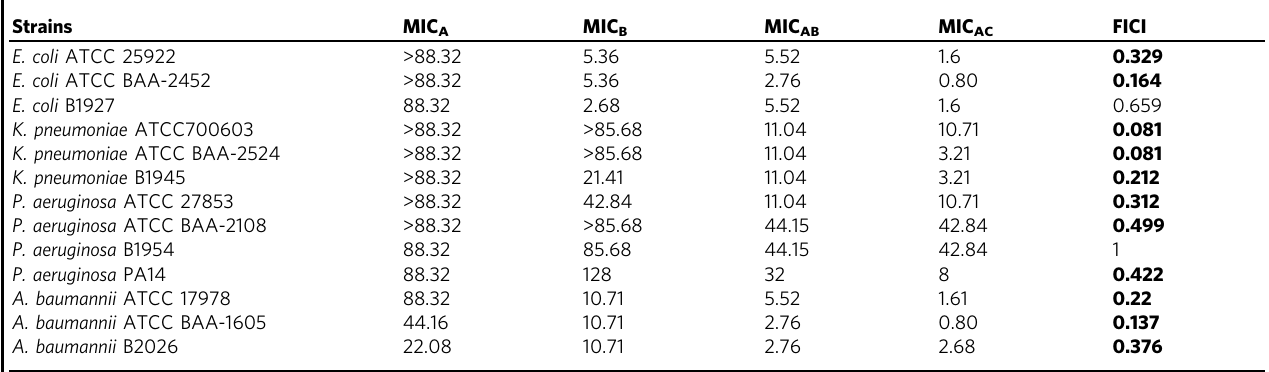
Table 4 Combined activity of D-11 and vancomycin ( µ M) against an extended panel of MDR Gram-negative clinical isolated